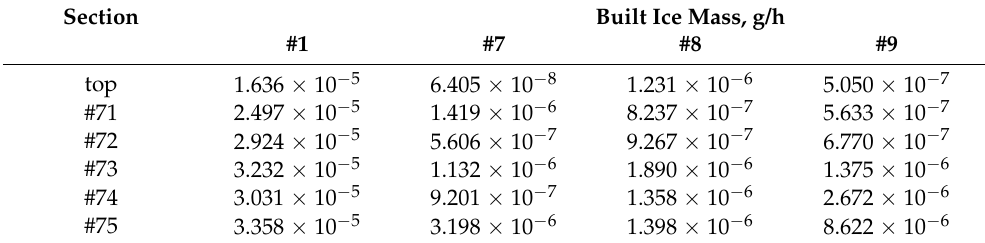
Table 5. Comparative table of built ice mass for columns #1, #7, #8 and